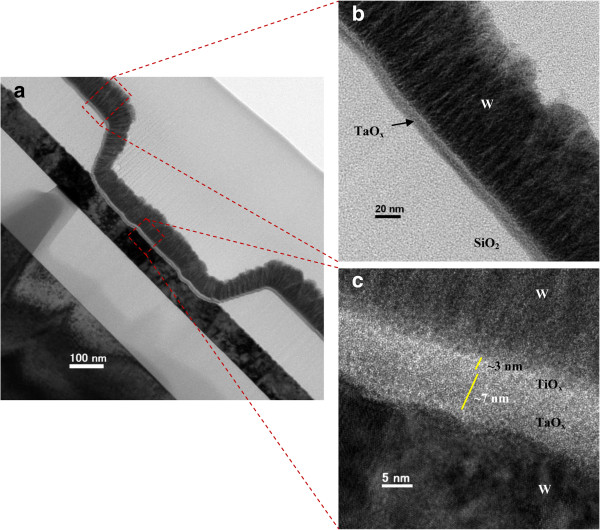
TEM image of W/TiOx/TaOx/W structure. (a) Cross-sectional TEM image with a typical device size of 0.6 × 0.6 μm2. HRTEM images of (b) outside and (c) inside via-hole regions.